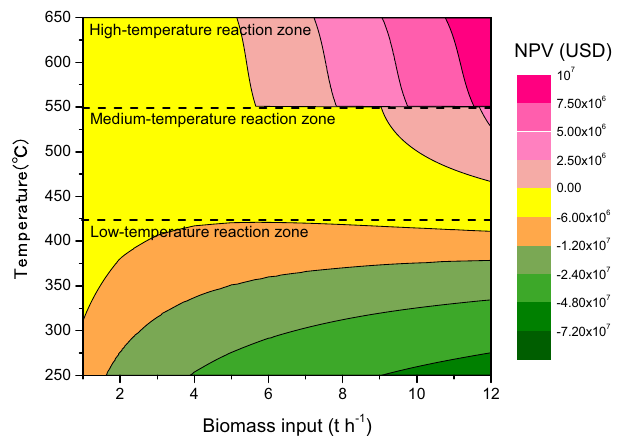
Fig. 2 The two-factor sensitivity analysis for net present value. Note that there is a step change at 550 °C caused by the pyrolysis gas price change in different regimes of heating value (shown in Supplementary Note